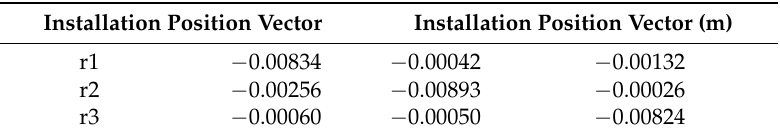
Table 3. Dynamic calibration for accelerometer unit.